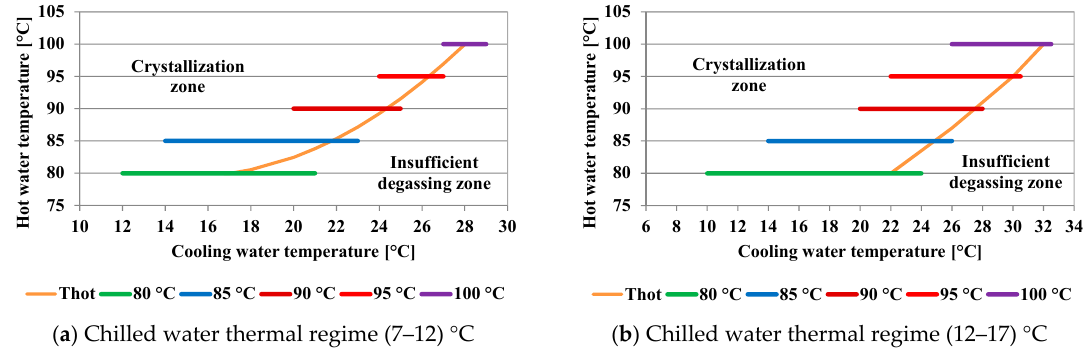
Figure 13. Acceptable operating ranges.